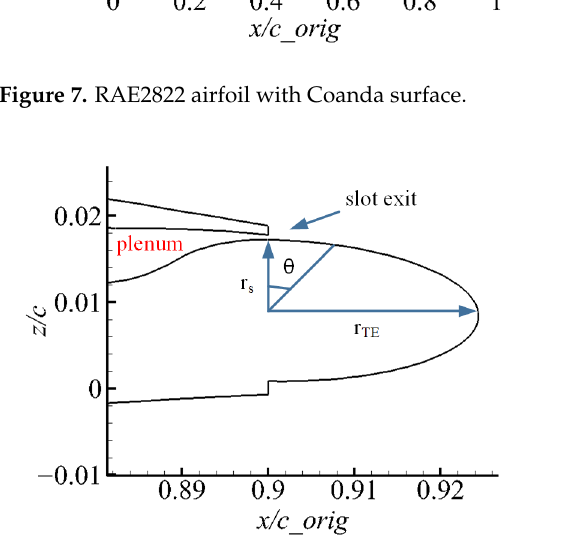
Figure 8. Trailing edge of the RAE2822 airfoil.